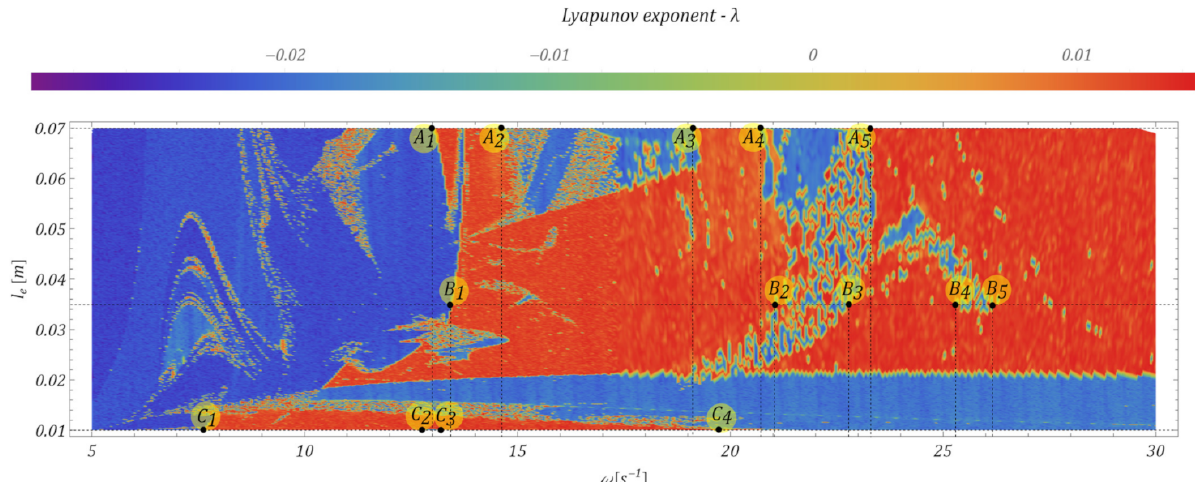
Figure 9. Multicolored map of the largest Lyapunov exponent generated under zero initial conditions, presented in the form of a two-dimensional graph based on arm length ( l e ) and frequency ( ω )